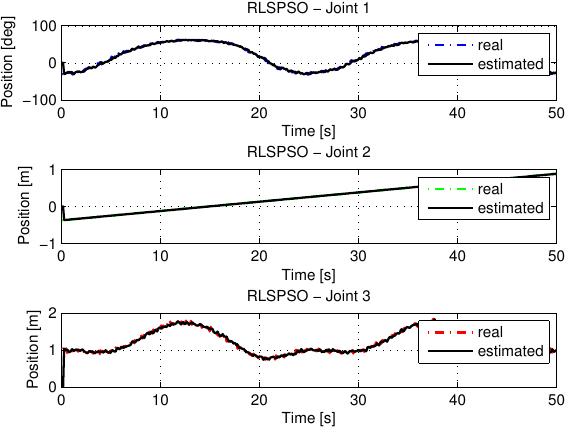
Figure 33. Trajectory in the joint space identified with RLSPSO with